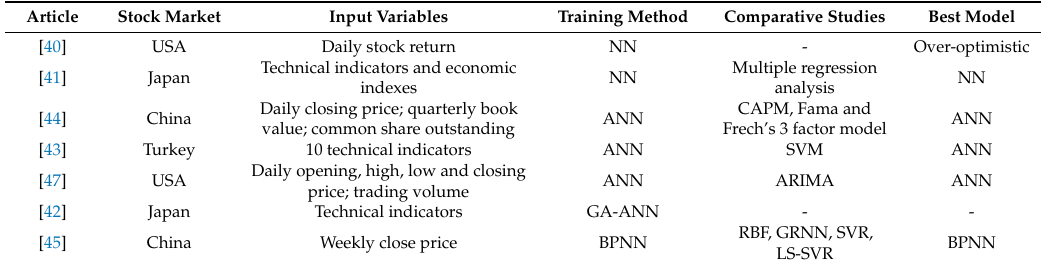
Table 3. Summary of artificial neural network (ANN)-based prediction methods used by this study’s